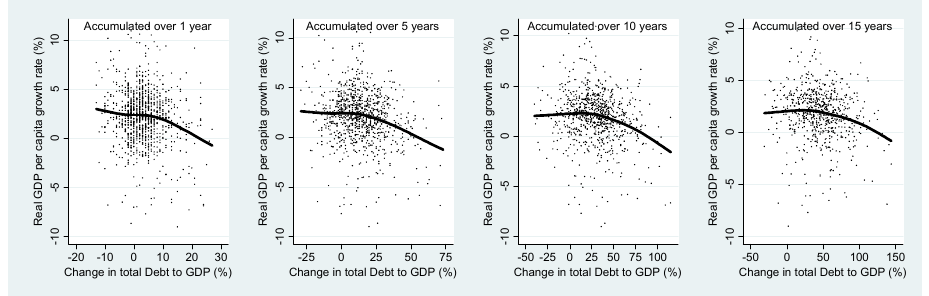
Figure 10 - Growth performance over 1 year with debt accumulation over 1-15 year (h=1 and